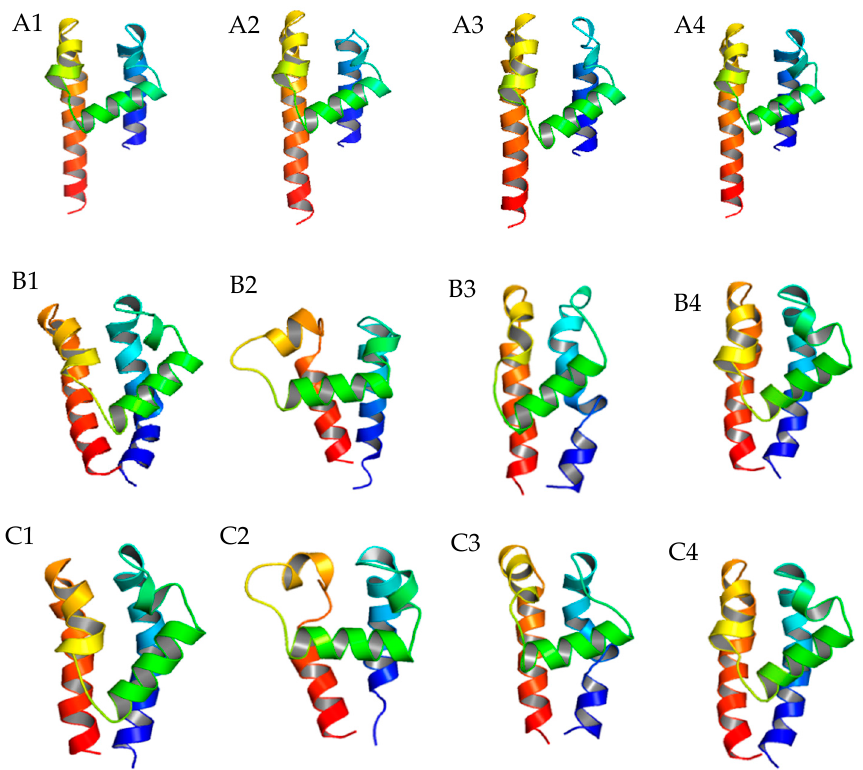
Figure 2. Comparison of the P-loop conformation differences before and after Rosetta P-loop remodeling. ( A ) Homology modeling of P-loop structures of α 1 G domain I ( A1 ), domain II ( A2 ), domain